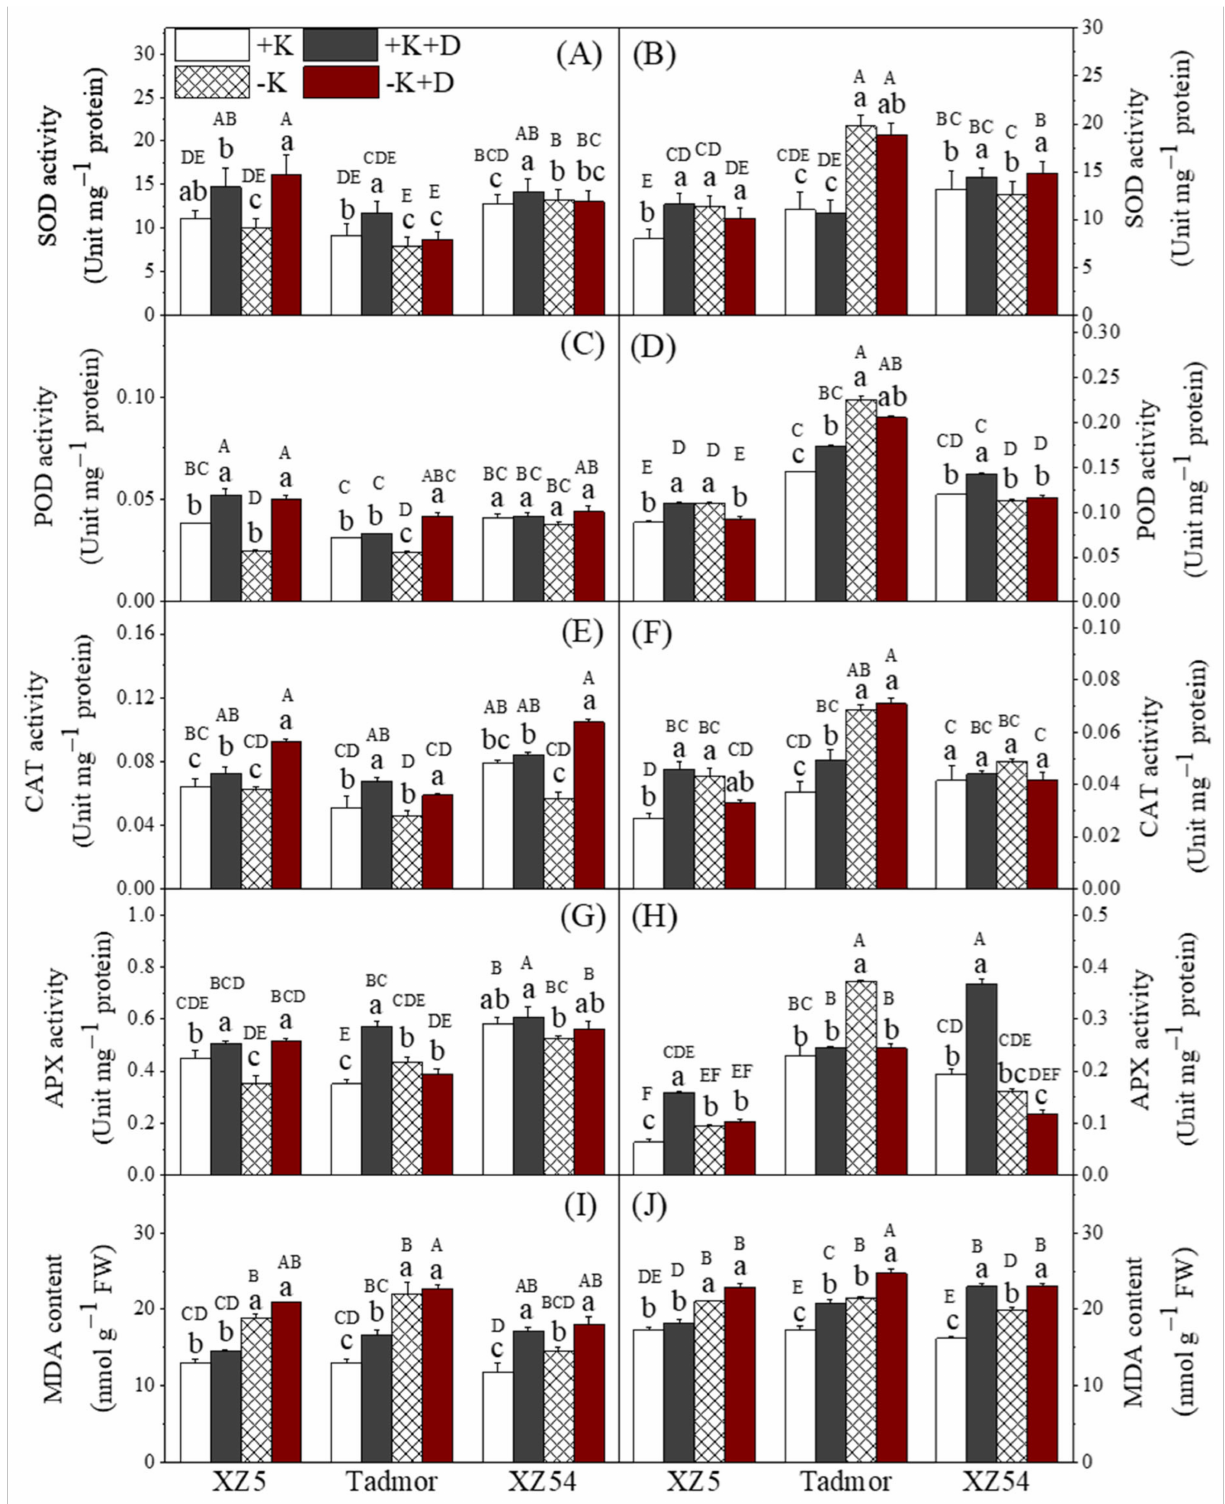
Figure 1. Effect of alone and combined stress of drought and K deprivation on antioxidant enzyme activities of SOD ( A , B ), POD ( C , D ), CAT ( E , F ), APX ( G , H ) and MDA contents ( I , J ) in leaves (left panel) and roots (right panel) of three barley genotypes. Different capital and small letter(s) indicate significant differences ( p < 0.05) among the genotypes and among the 4 treatments within each genotype, respectively. +K (control), +K+D, –K, and –K+D, correspond to basic nutrition solution with normal K of 1 mM K (BNS), BNS + 20% polyethylene glycol 6000 (PEG), BNS without K (K deprivation), and BNS without K + PEG, respectively. Error bars represent standard deviations ( n =